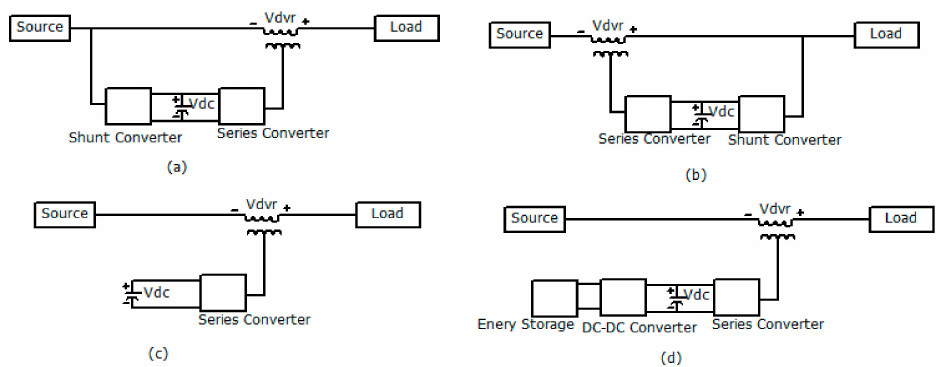
Figure 3. Typical topologies of DVRs: ( a ) without energy storage supply side connected DVR; ( b ) without energy storage load side connected DVR; ( c ) self-charging (capacitor supported) DVR; ( d ) with external energy storage DVR.